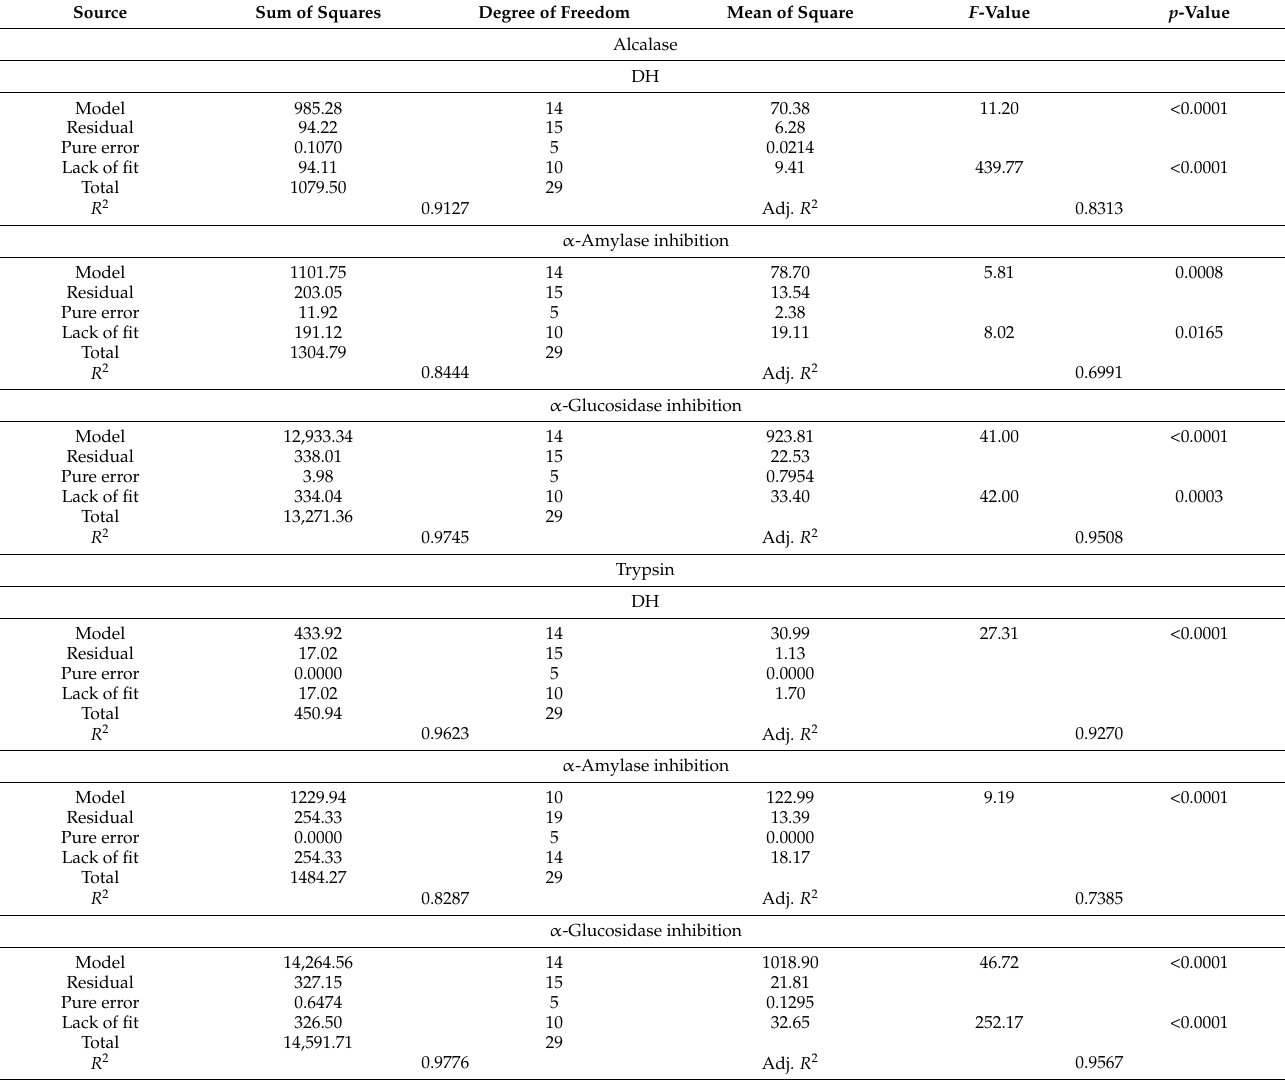
Table 2. Analysis of variance for three responses with two